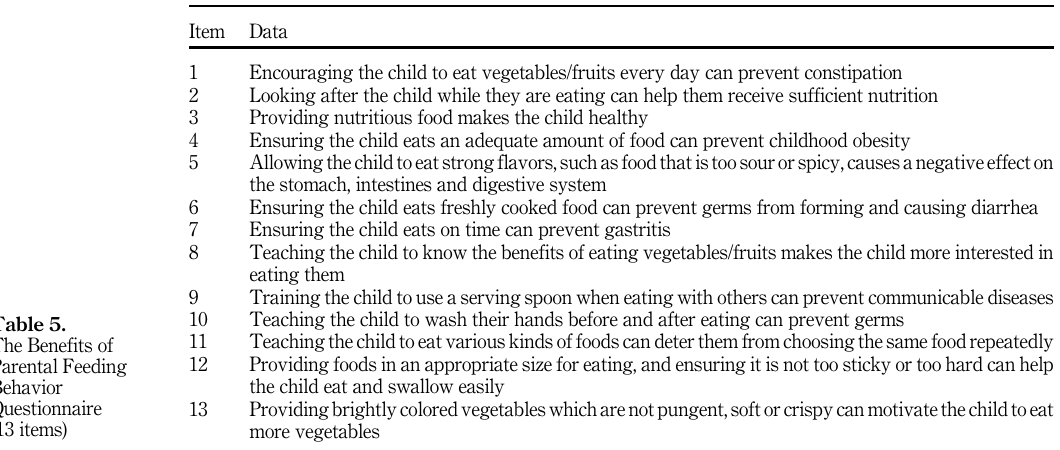
Table 5. The Benefits of Parental Feeding Behavior Questionnaire (13 items)